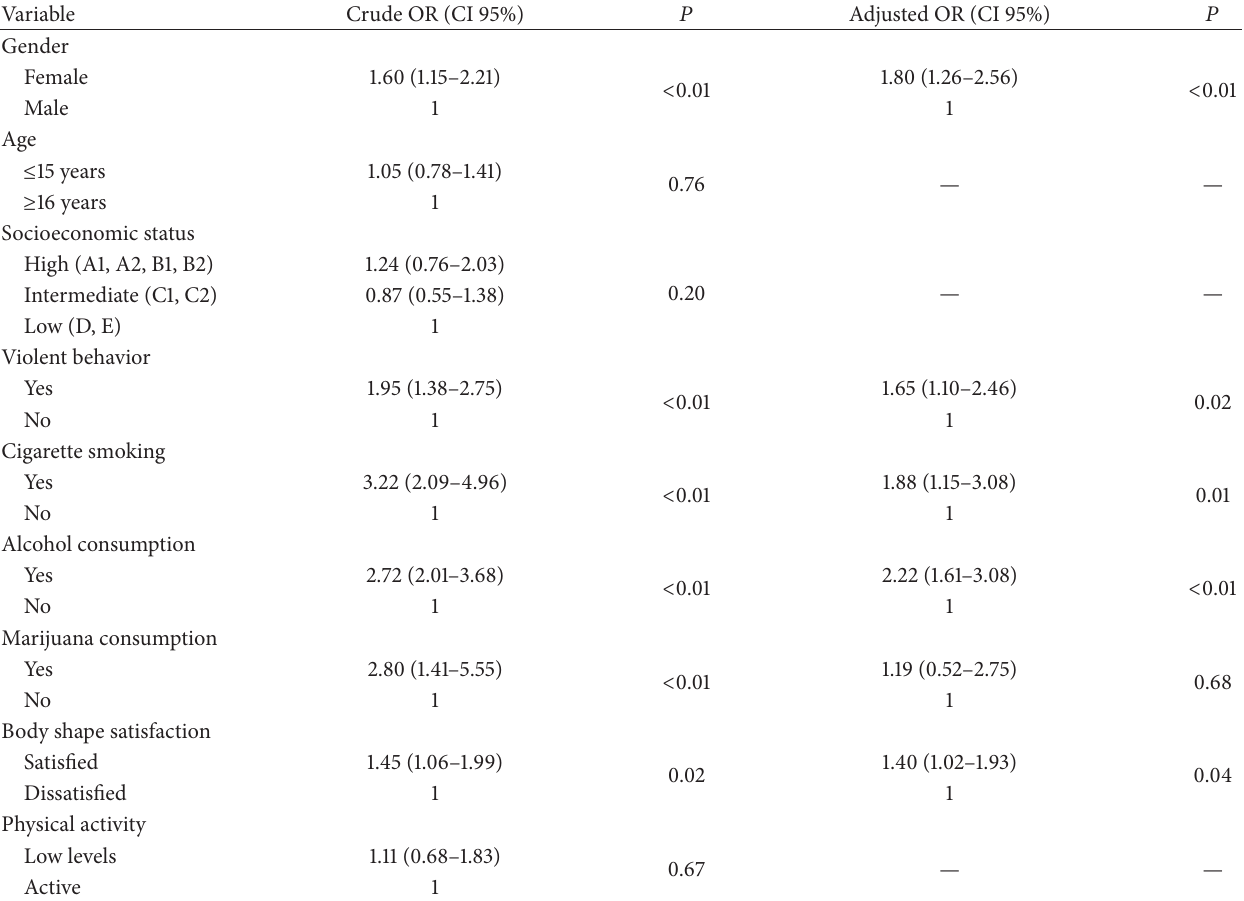
Table 4: Crude and adjusted odds ratio for behavior “suicide plan” among adolescents in Northeastern Brazil, 𝑛 = 2207.